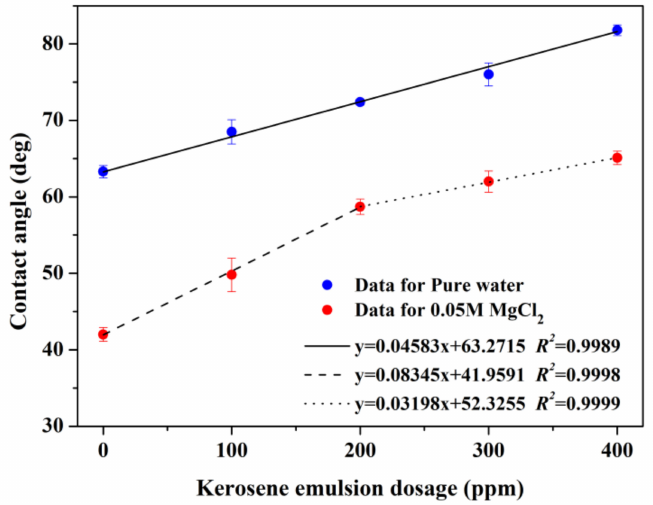
Figure 6. Contact angles of chalcopyrite surface as a function of kerosene emulsion